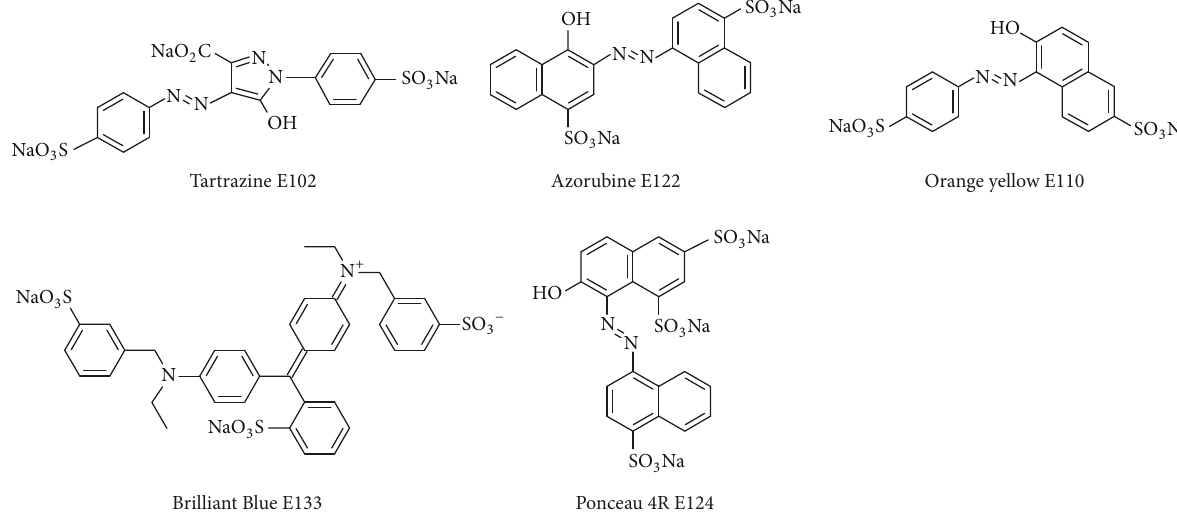
Figure 1: Structures of dyes E102, E110, E122, E124, and